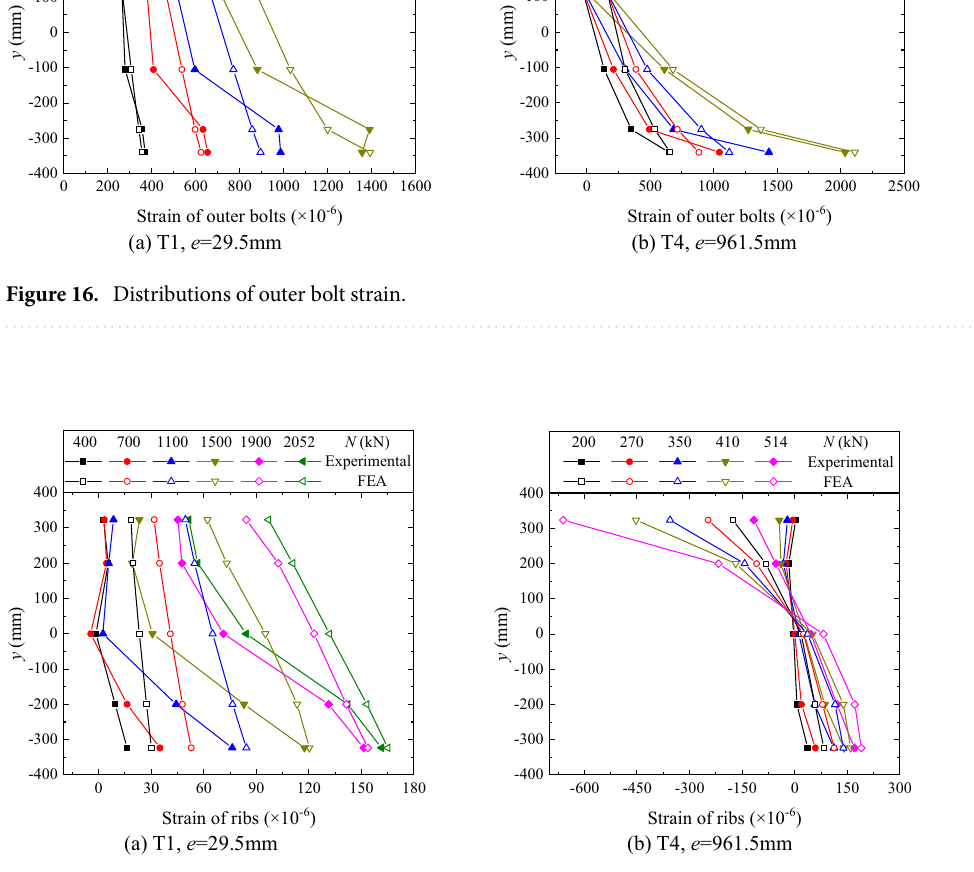
Figure 17. Distributions of rib